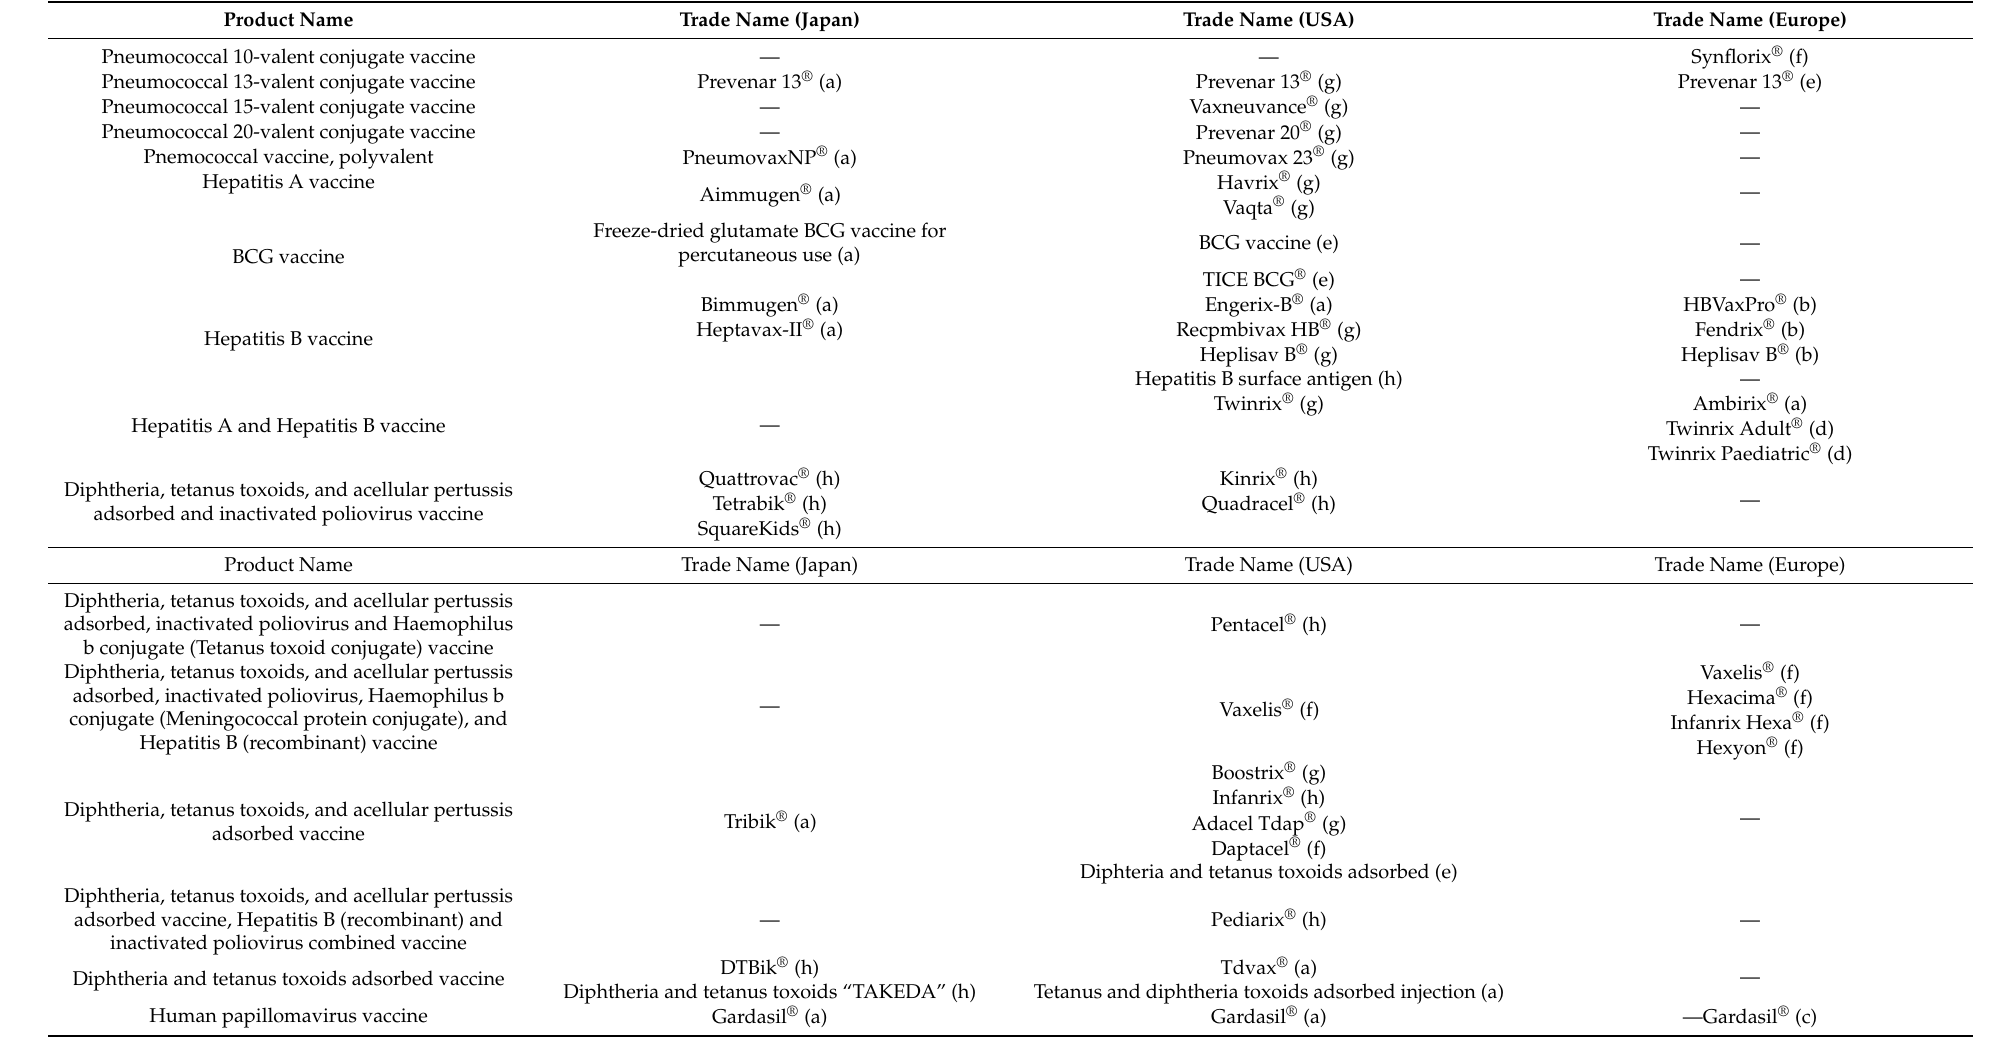
Table 1. List of vaccines examined in this